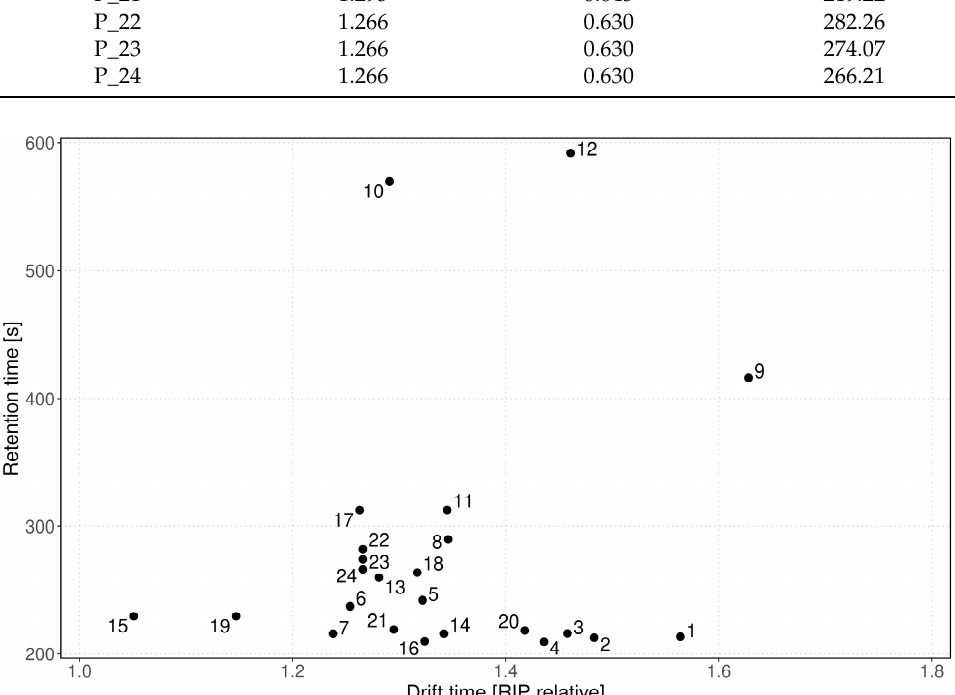
Figure 2. Pattern (GC retention time vs. IMS drift time) of the detected 24 mVOCs in the headspace of E. coli -infected blood cultures. The peaks are numbered according to Table 1 and listed there with their particular retention-/drift times and 1/K0.